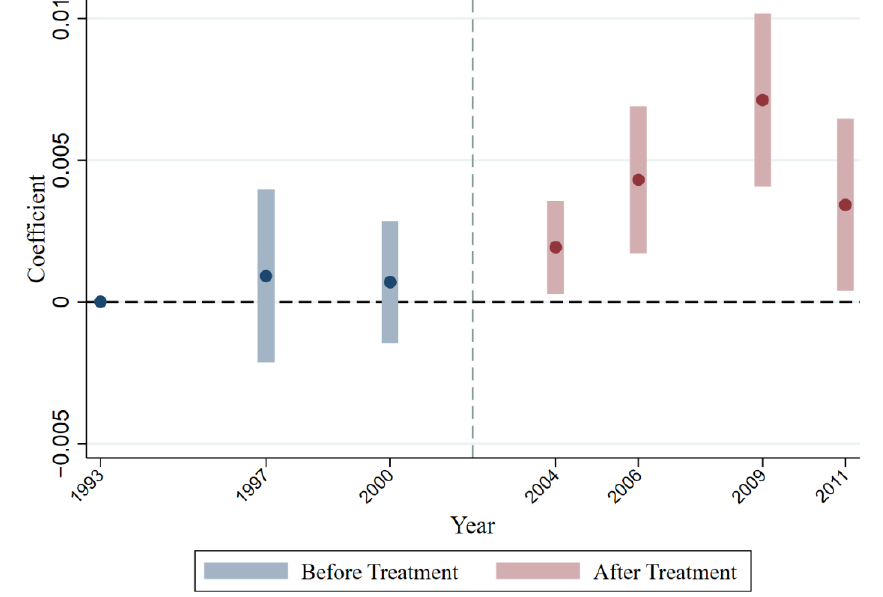
Figure 1. Illustration of the common trend prior to accession to the WTO. Table 3. Dynamic and expectation effect.